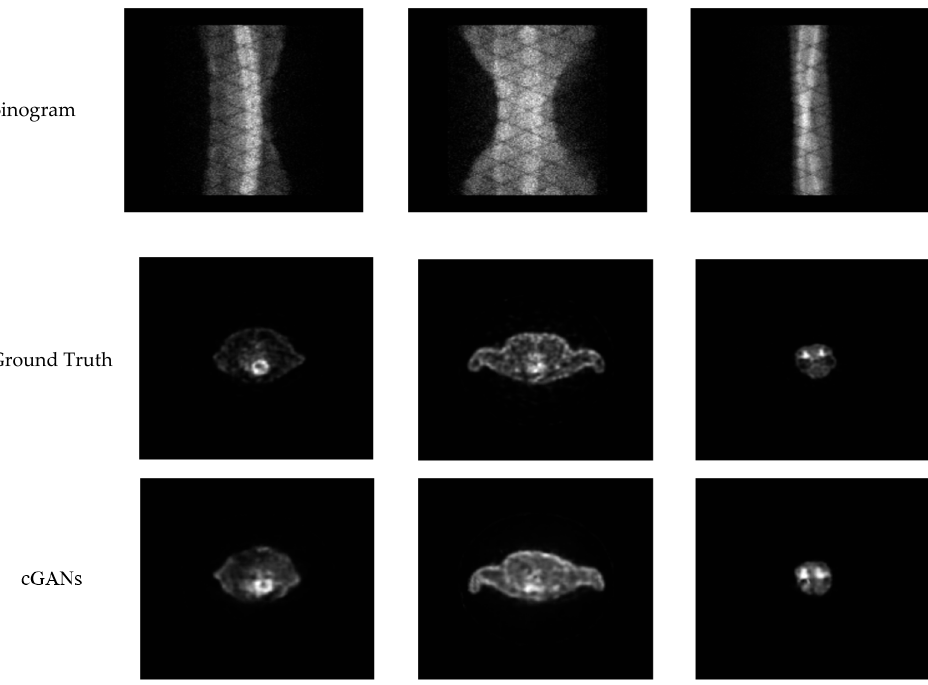
Figure 13. Reconstruction results of different slices of SD rats. From top to bottom: sinogram images, ground truth (OSEM), reconstruction results of cGANs.